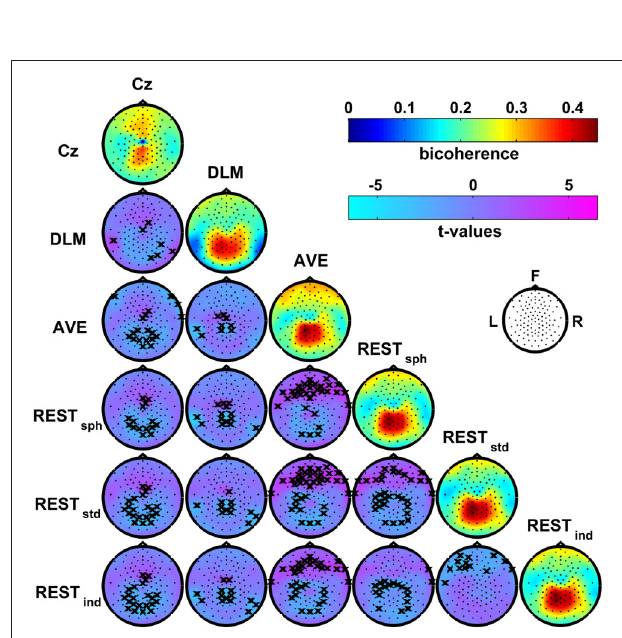
FIGURE 4 | Effects of the EEG reference choice on alpha-beta bicoherence patterns estimated from resting state EEG data. Main diagonal: maps of the average bicoherence across subjects obtained for the different EEG reference schemes. Off-diagonal: maps of t -values for pairwise contrasts between bicoherence maps from different EEG reference schemes using a paired-sample t -test; the black crosses mark the channels showing significant differences at the p < 0.05 level (two-tailed) based on a permutation test (10,000